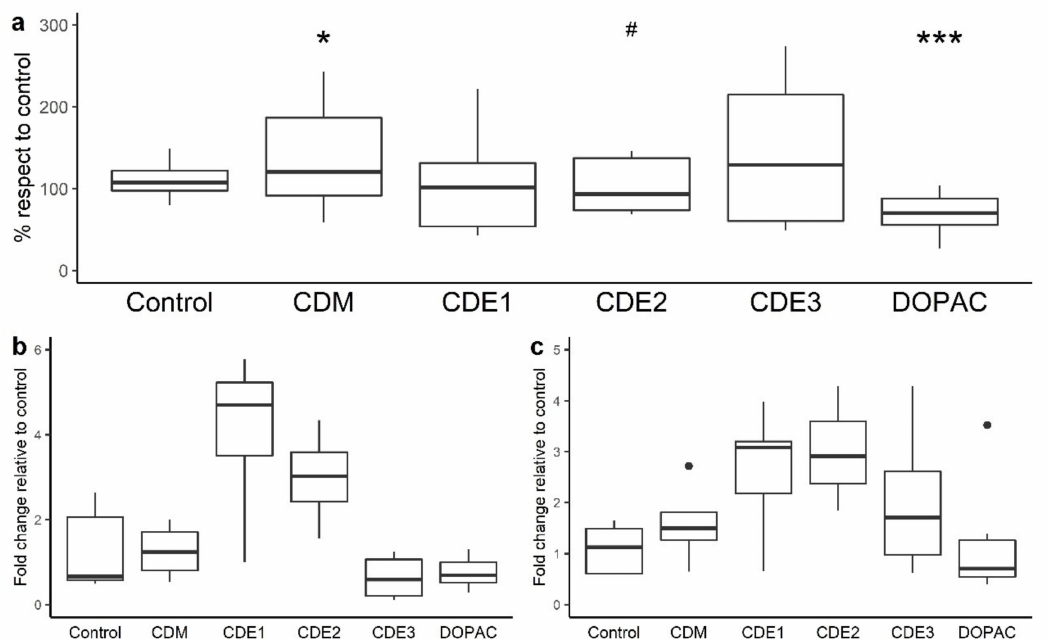
Figure 3. The effects of colonic intestinal medium (CDM), 3,4-dihydroxyphenylacetic acid (200 µ M), and colonic digested extracts (CDE1, CDE2, CDE3) after 16 h incubation on the paracellular permeability in Caco-2 cells ( a ) and on ZO-1 ( b ) and occludin gene expression ( c ) . The t test was employed to check for differences in each treatment with respect to the control (* significant differences at p < 0.05; *** significant differences at p < 0.001). Also, the t test was employed to check for differences in CDEs with respect to CDM (# significant differences at p < 0.05). CDM: Colonic digestion medium. CDE: Colonic-digested